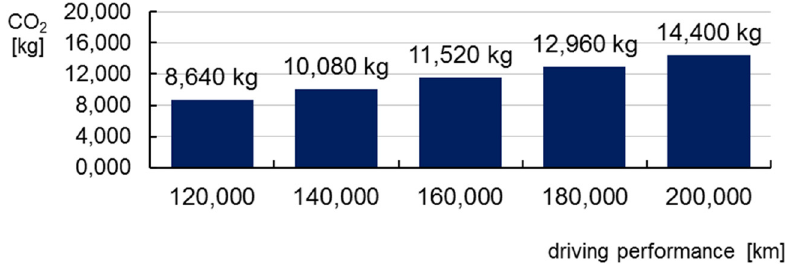
Figure 7: Di ff erence in CO 2 production between the compared trucks with trailers depending on the annual driving performance in km.